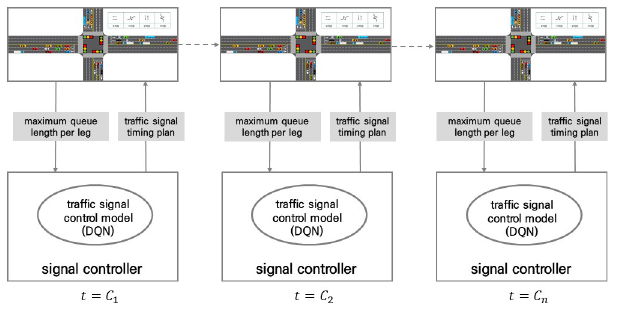
Fig 4. Concept of traffic control method for isolated intersection.